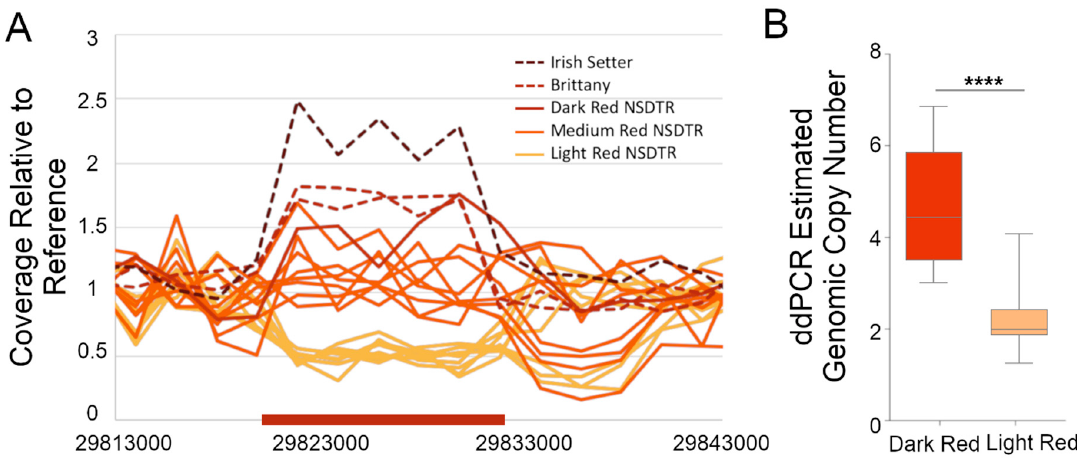
Figure 2. Relative coverage across the region of the KITLG CNV. ( A ) Relative coverage from paired-end whole-genome sequencing is plotted on the y -axis, and CanFam3.1 chr15 base pair position is plotted on the x -axis. The region of the CNV is marked by the red bar on the x -axis. Each line represents a single individual dog, and the color of the line represents the coat color of that dog. The solid lines represent NSDTR and the dashed lines represent Brittanys and an Irish Setter. ( B ) NSDTR comparison between light and dark dogs using digital droplet PCR to estimate the copy number. Comparison using a Mann–Whitney test. p = 4.1 × 10 − 11 . Dark red, n = 28. Light red, n = 34. **** = highly